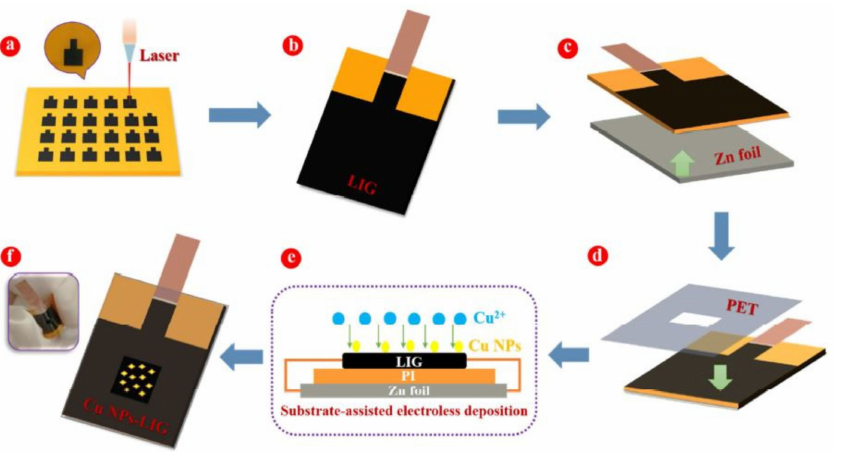
Figure 5. Schematic illustration of the fabrication of the Cu nanoparticles (NPs)-modified LIG-based sensors [142]. ( a ) The laser induction of the PI films was done ( a ) The LIG was formed form PI films. ( b ) A part of the films was the induction process was carried out, ( c ) it was connected to zinc films. ( d ) The whole structure was encapsulated with PET films and ( e , f ) dipped into copper sulfate solutions to form Cn-functionalized LIG sensors. Copyright 2020